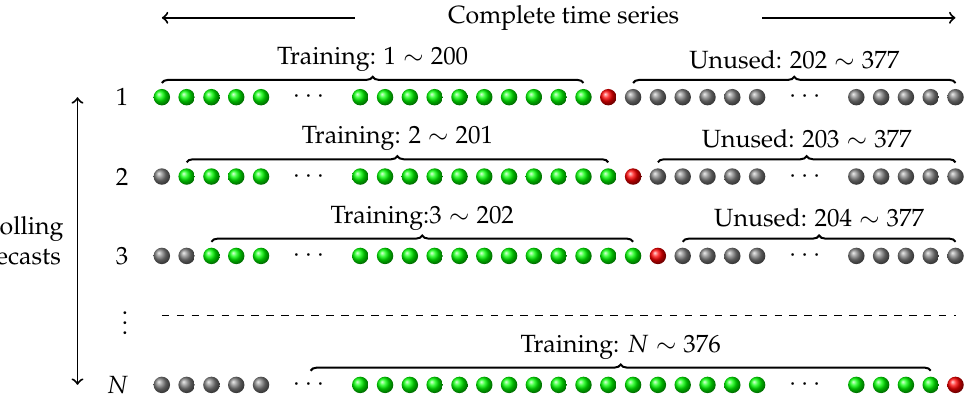
Figure 2. Experimental design, following Yang et al. [22]. A total of N = 177 rolling forecasts are performed for each UPC time series. The data point being forecast is shown in red. The size of training window (shown in green) is fixed at